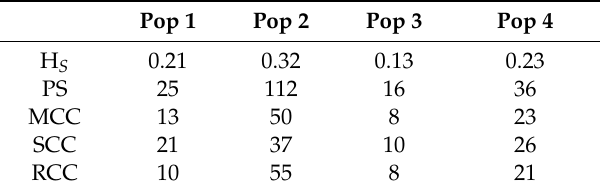
Table 1. Genetic diversity (H s ) of DArT (Diversity Array Technology) markers in each population (Pop) of the primary set and final number of accessions from each population in the core